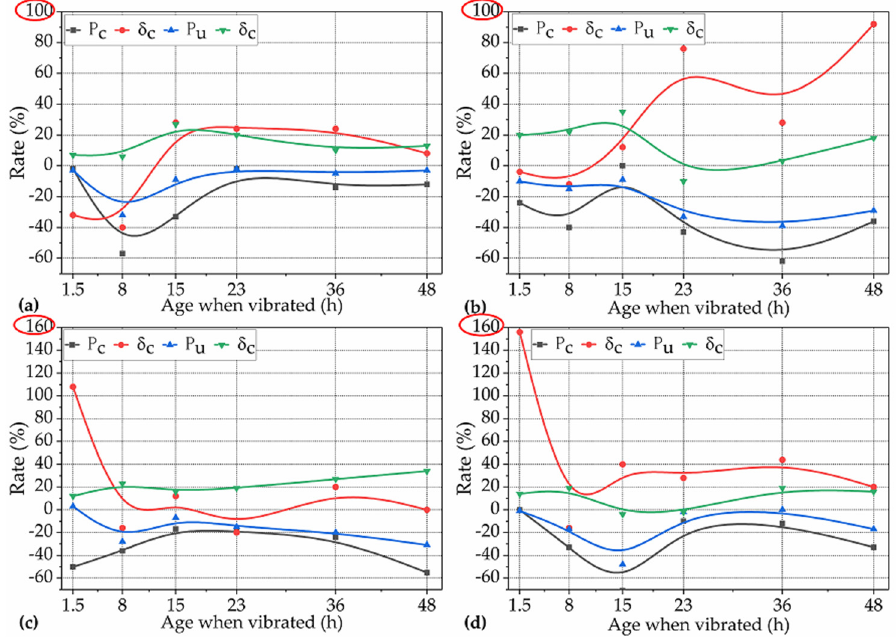
Figure 6. Rates of P c , δ c , P u , and δ u for the 24 groups of specimens over the corresponding control averages under the operating conditions for Var. 1 with frequencies of ( a ) 2 Hz, ( b ) 3 Hz, ( c ) 4 Hz, and ( d ) 5 Hz.